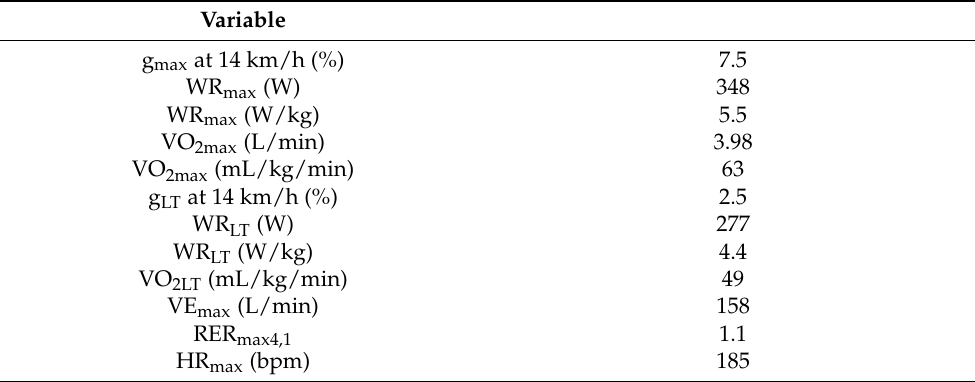
Table 6. Value of the maximal and lactate threshold workload and selected cardiorespiratory variables registered during Cardio-Pulmonary Exercise Test CPET before the competition.